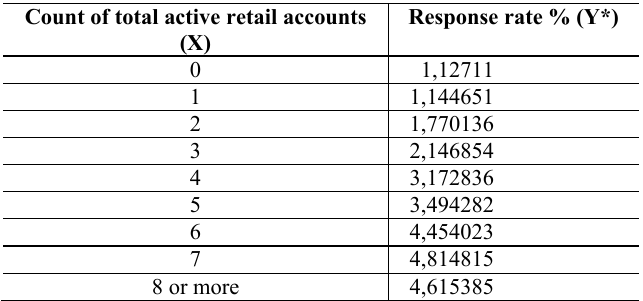
Table 3: Response rate percentages